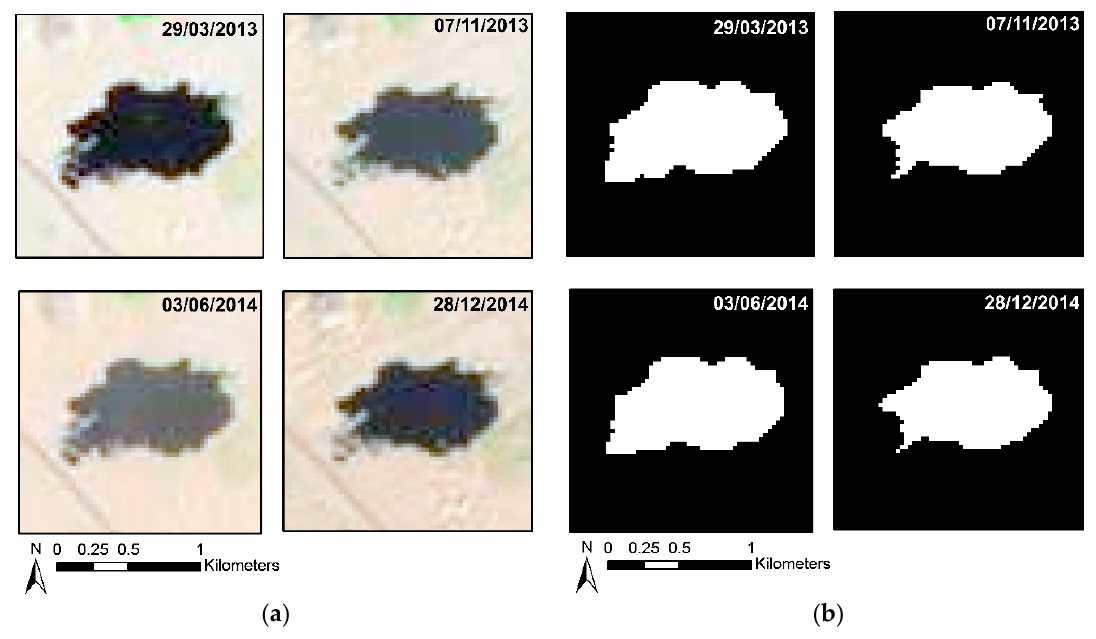
Figure 2. ( a ) Landsat 8 images at four different periods of Lake Zakher. ( b ) Extracted polygons using the morphological gradient from respective Landsat images.